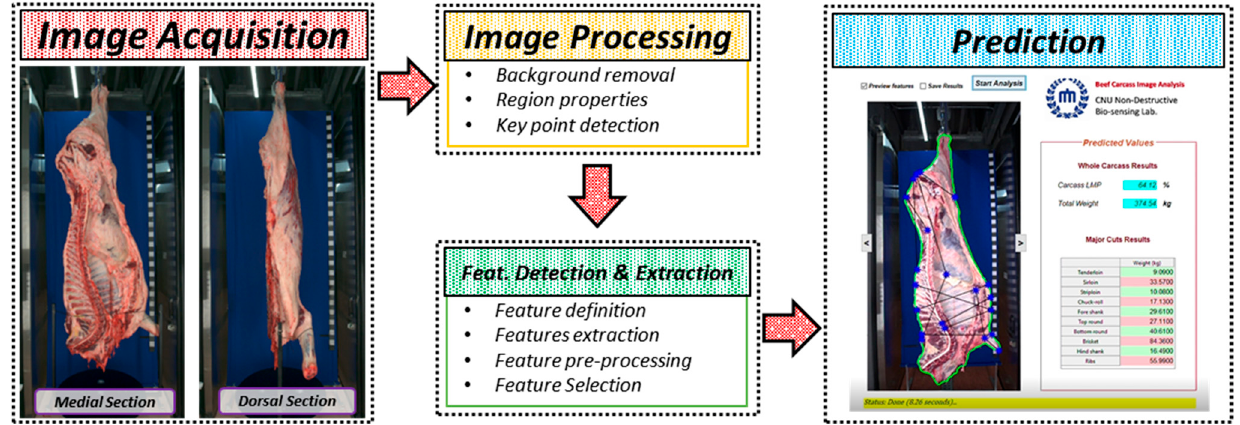
Figure 2. Schematic of operations from image acquisition to final yield predictions.